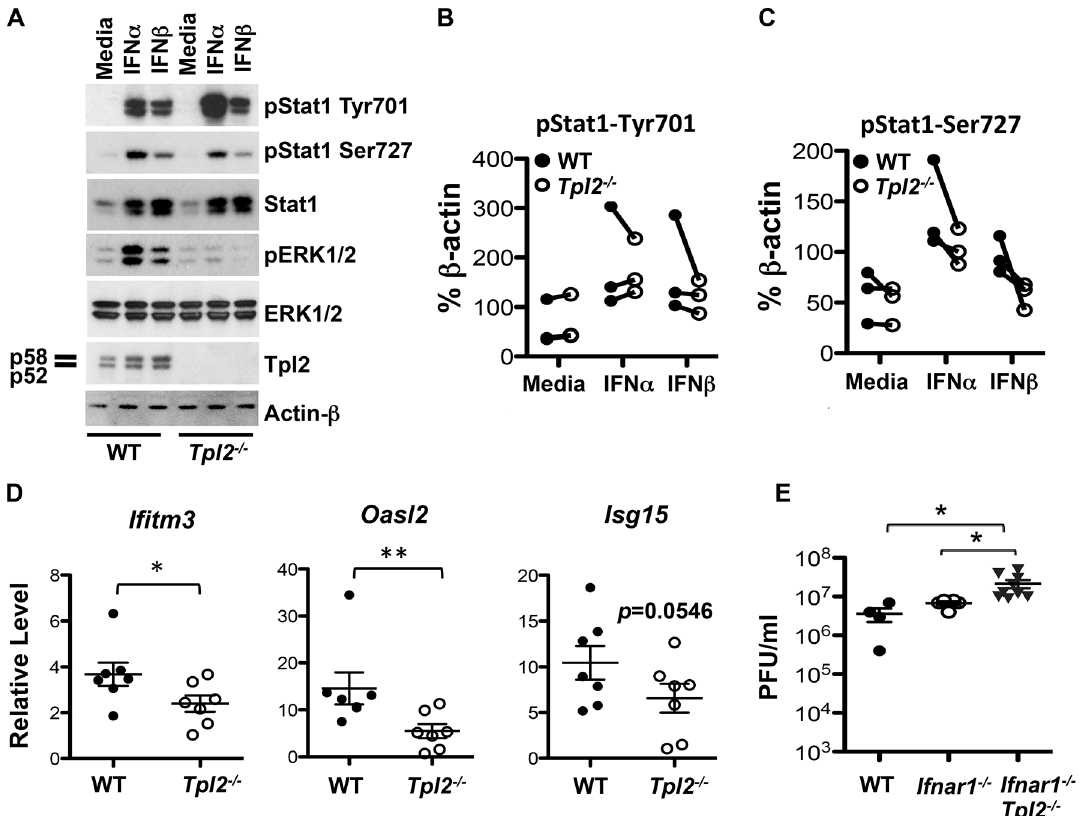
Fig 6. Tpl2 mediates IFN signaling and induction of ISGs. (A) BMDMs from WT and Tpl2 -/- mice were stimulated with IFN α or IFN β for 1 hr, and STAT1 and ERK phosphorylation were assessed by immunoblotting. Data are representative of 3 independent experiments. Average intensities of pSTAT1 Tyr701 (B) and pSTAT1 Ser727 (C) bands normalized to actin bands by densitometric analysis. Data collected on the same day are connected by lines. (D) WT and Tpl2 -/- mice were infected with 10 6 pfu of X31 virus, and the expression of Ifitm3 , Isg15 and Oasl2 in lung tissue D1 pi was measured by RT-PCR with normalization to actin mRNA and WT uninfected sample (n = 7). (E) WT, Ifnar1 -/- and Ifnar1 -/- Tpl2 -/- mice were intranasally infected with 10 4 pfu of X31 virus, and lung viral titers on D3 pi were enumerated by plaque assays; n = 4 WT, 5 Ifnar1 -/- and 9 Ifnar1 -/- Tpl2 -/- mice. * indicates p < 0.05, ** indicates p < 0.01.